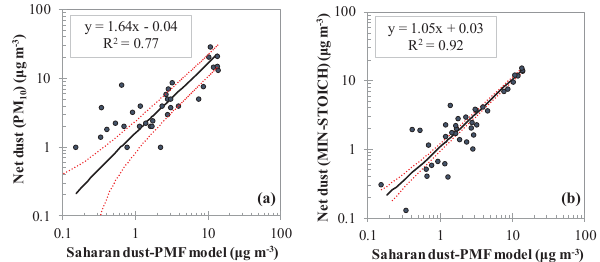
Figure 8. Deming regression analysis of net dust concentrations cal- culated from regional background PM 10 and PMcoarse (PM 2 . 5 − 10 ) concentrations for Athens (left) and Barcelona (right). The black line corresponds to the linear regression equation, while the red dot- ted lines are the upper and lower bounds, at the 95% confidence